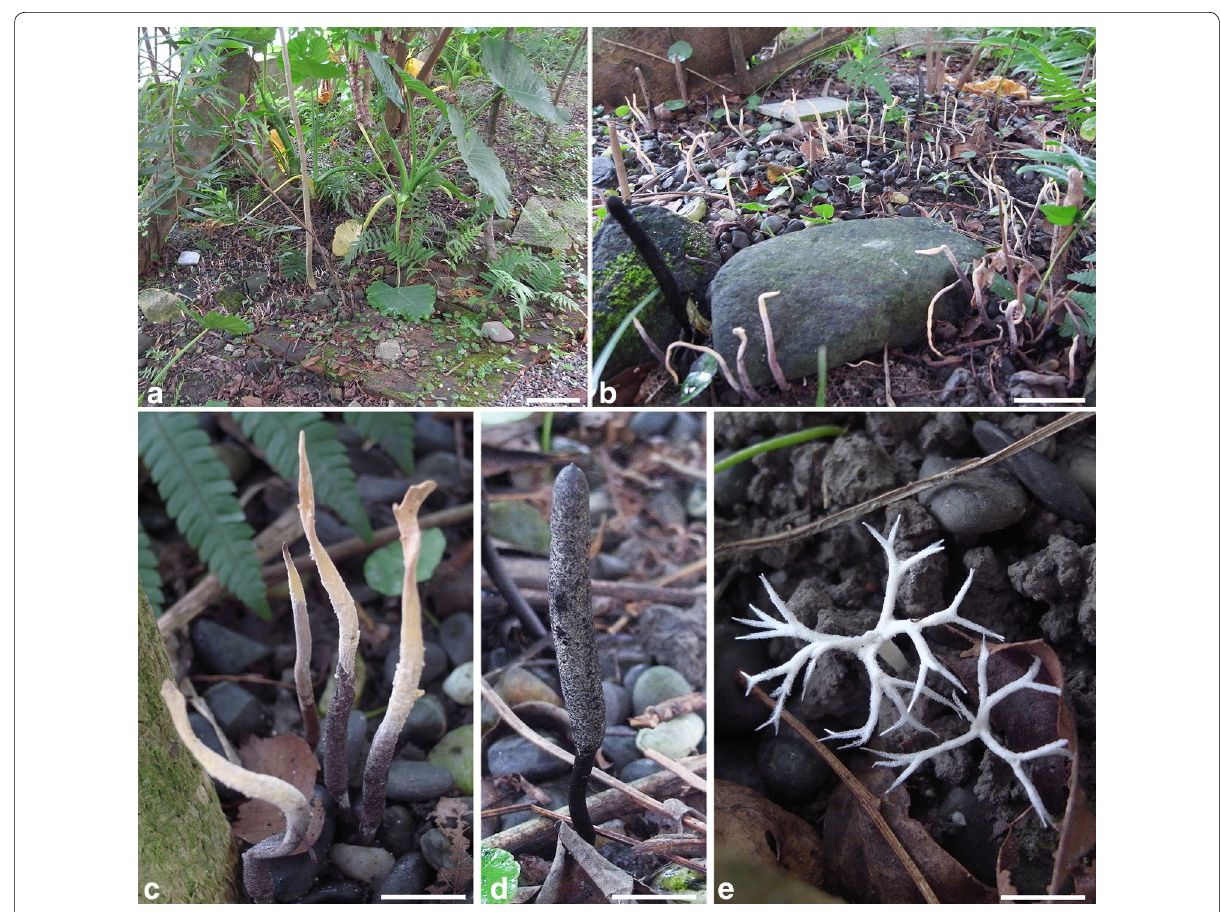
Fig. 1 Collecting site, X. brunneovinosa , X. escharoidea , and X. furcata . a , b Collecting site. a Overall view. b Area where stromata are most populated. c Stromata of X . brunneovinosa with the upper portion still overlain with luteous conidial masses. d Stroma of X . escharoidea . e Immature stromata of X . furcata . Bars in a 10 cm; b 2 cm; c , d 1 cm; e 5 = = = =